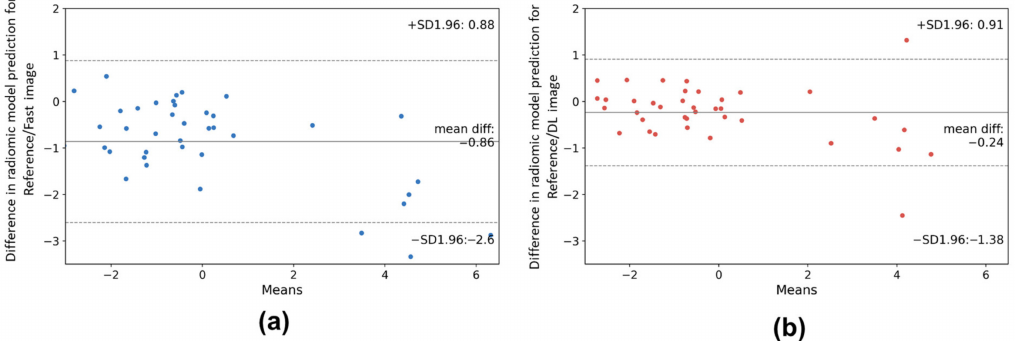
Figure 5. Bland–Altman plots showing the difference between predictive values obtained from the radiomic model [29] and reference images to fast downsampling images ( a ) and DL resampling image ( b ) in brain metastatic lesions.